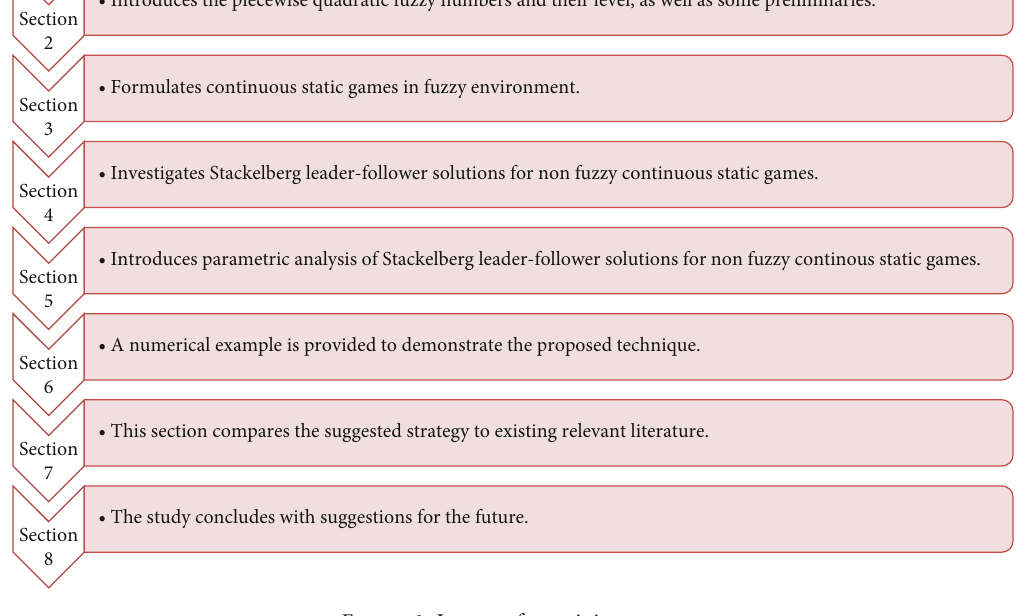
Figure 1: Layout of remaining